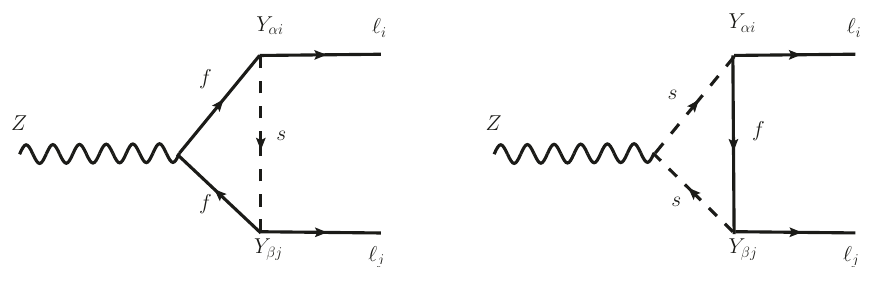
Figure 12 . Representative diagram for Z → ‘ i ‘ j processes. Here f = χ 0 , χ 1 , L 1 , L 2 and s ∈ η, S . The indices stand for i, j = e, µ, τ and α, β = 1 , 3 , 4 (see eq. (2.14)). Y Y 1 e 3 e